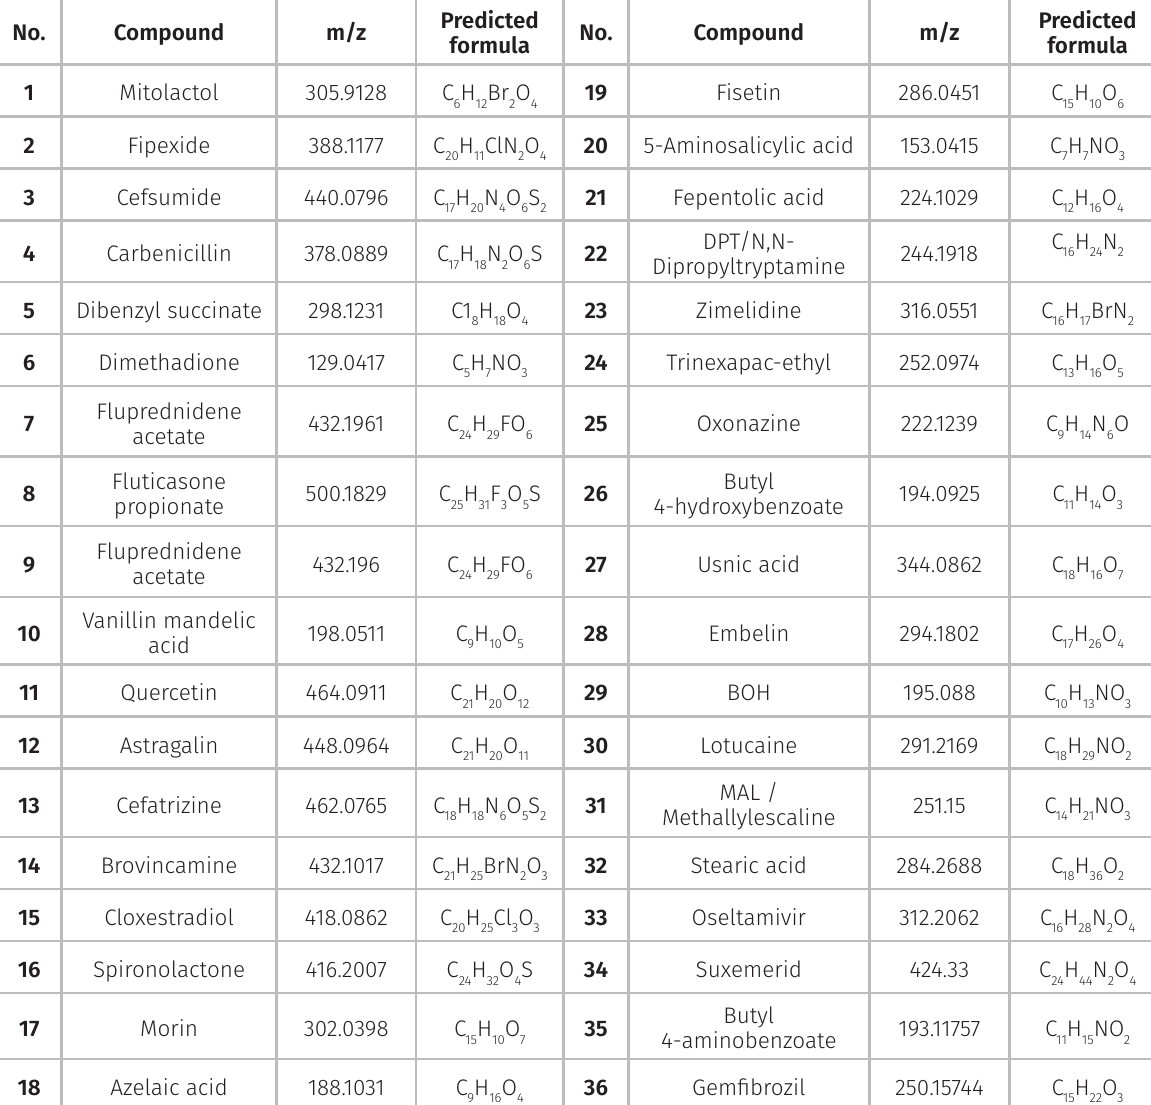
Table II. Identification of 36 compounds in P. Odorata leaf extract by HPLC-EIS-MS.